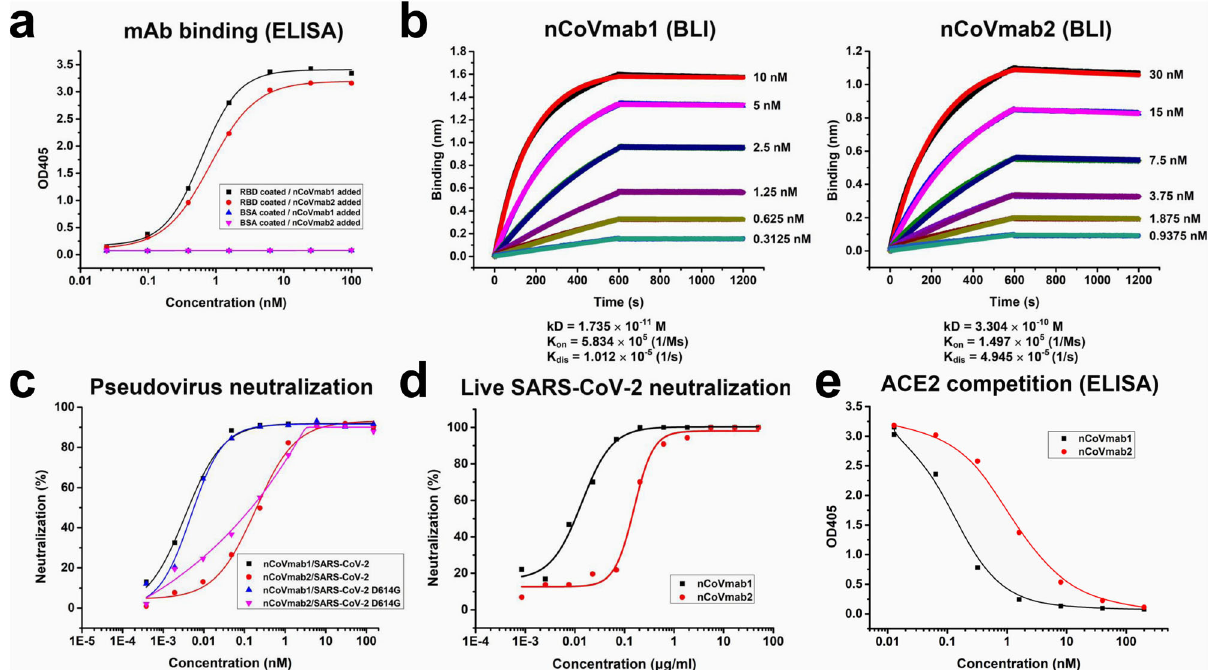
Fig. 2 Activity identi fi cation of nCoVmab1 and nCoVmab2. a The binding of nCoVmab1 and nCoVmab2 to the RBD, as measured by an ELISA. Both nCoVmab1 and nCoVmab2 could speci fi cally bind to the RBD antigen. The experiments were performed independently three times and similar results were